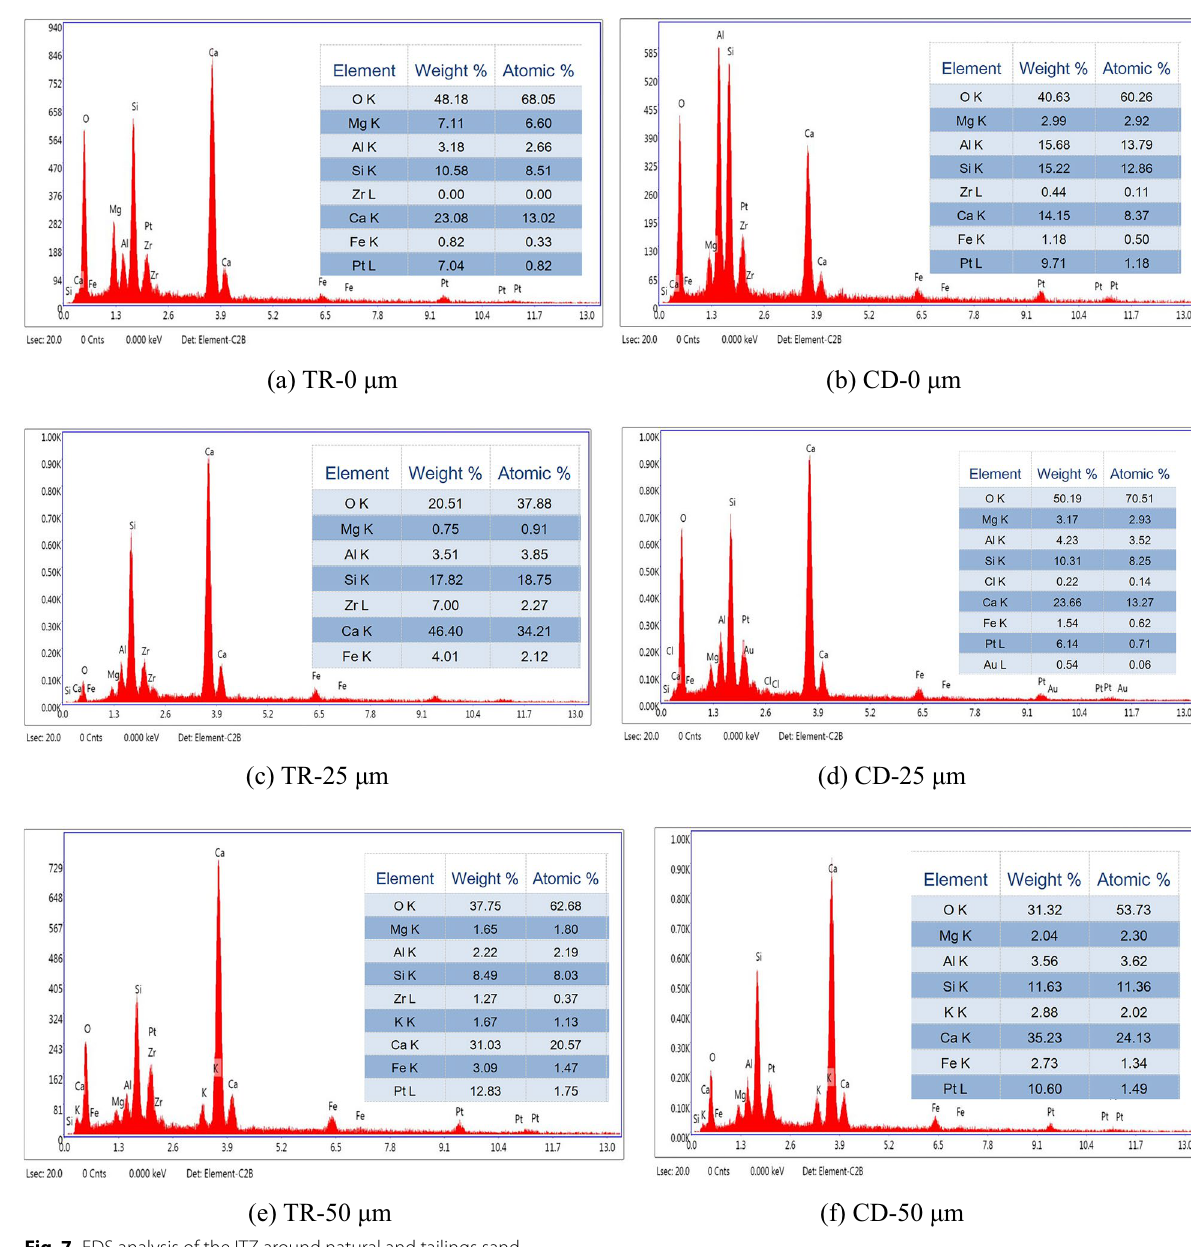
Fig. 7 EDS analysis of the ITZ around natural and tailings